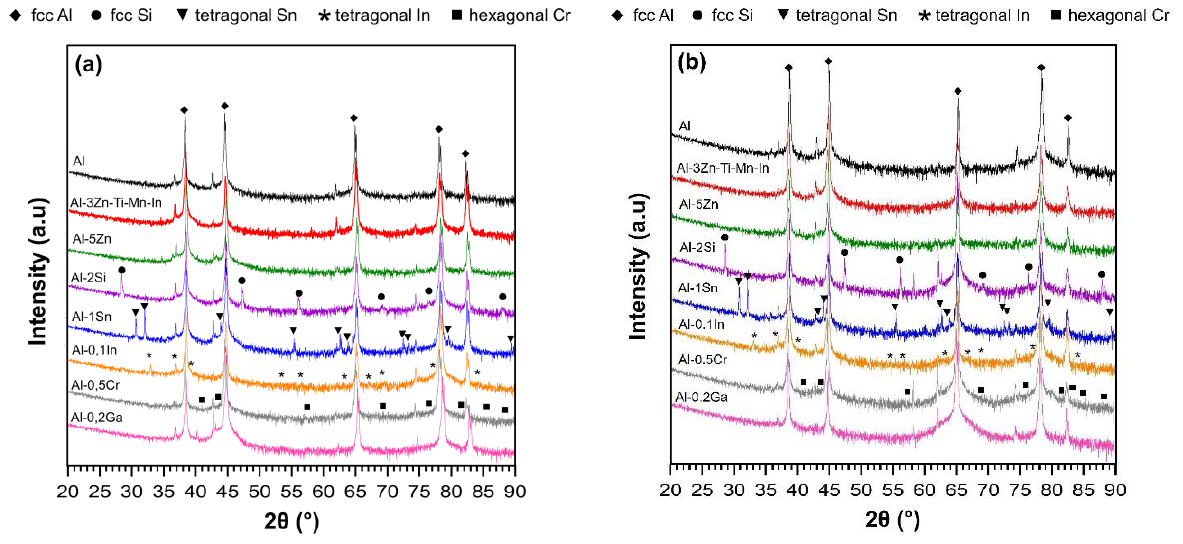
Figure 3. XRD spectra of Al-based alloys in: ( a ) as-cast and ( b ) 24 h solution treatment conditions, bold symbols indicate main phases according with the alloying element.